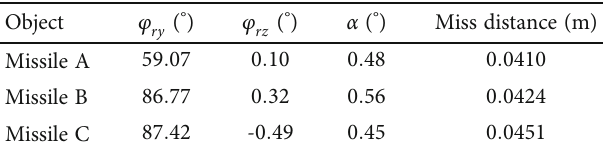
Table 3: Actual LOS angle, attack angle, and miss distance results at missile impact